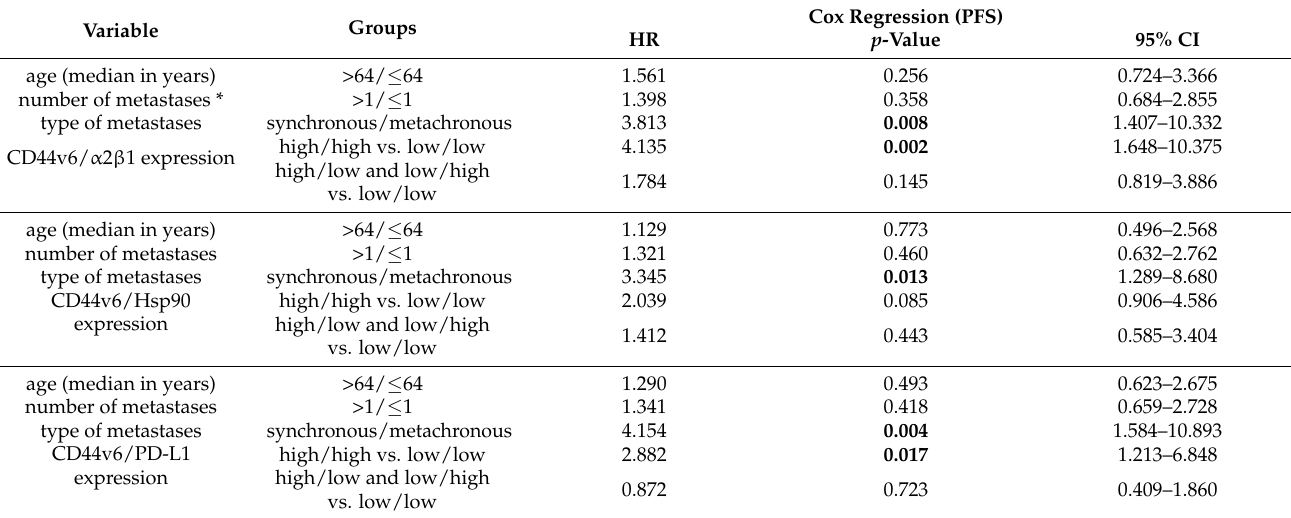
Table 6. Multivariate Survival Analysis of CD44v6-Related Dual Biomarker Expression in Colorectal Liver